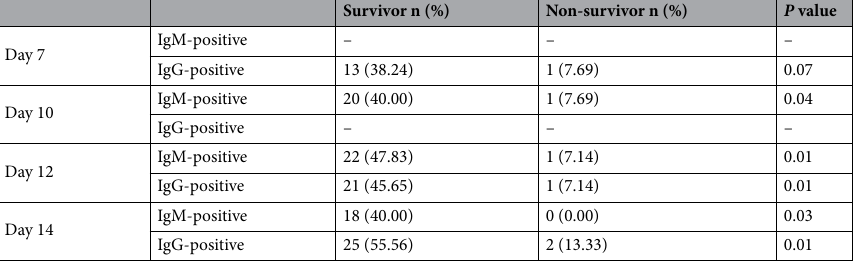
Table 3. Daily rates of IgM and IgG positivity (based on cutoff values). IgG positivity (day 7) is defined as IgG (day 7) ≥ 0.02 (0.02 is obtained from the ROC curve). IgM positivity (day 10) is defined as IgM (day 10) ≥ 0.08 (0.02 is obtained from the ROC curve). IgM positivity (day 12) is defined as IgM (day 12) ≥ 0.11 (0.11 is obtained from the ROC curve). IgG positivity (day 12) is defined as IgG (day 12) ≥ 0.58 (0.58 is obtained from the ROC curve). IgM positivity (day 14) is defined as IgM (day 14) ≥ 0.27 (0.27 is obtained from the ROC curve). IgG positivity (day 14) is defined as IgG (day 14) ≥ 1.65 (1.65 is obtained from the ROC curve). There are no differences in IgM (day 7) and IgG (day 10) between survivors and non-survivors. Therefore, the cutoff values for IgM (day 7) or IgG (day 10) are not set, and positivity rates are not set. Fisher’s test is conducted if sample numbers are less than 5. P < 0.05 indicates statistical significance. Ig immunoglobulin, ROC receiver operating curve.